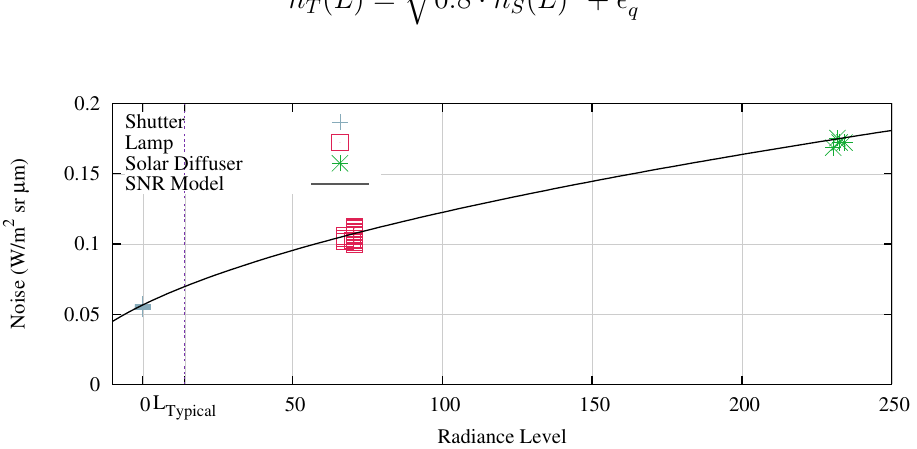
Figure 2. Example model of the signal-to-noise ratio